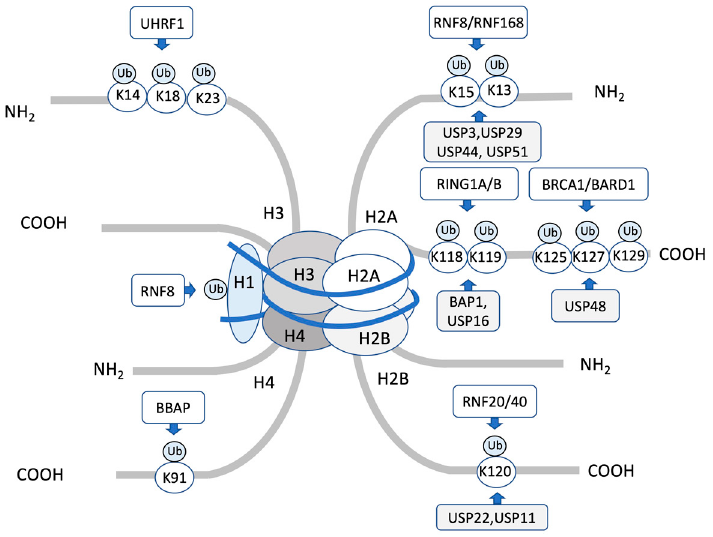
Figure 1. Summary of histone lysine ubiquitination and deubiquitination enzymes involved in DNA damage response. The E3 enzymes are listed above the ubiquitination site, whereas the deubiquitinating enzymes are listed below.